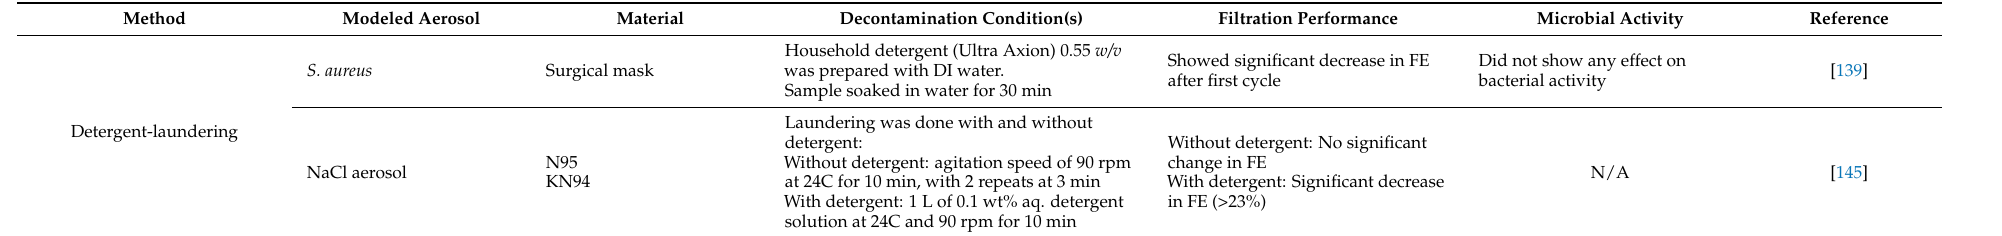
Table 14. Decontamination and regeneration using laundry